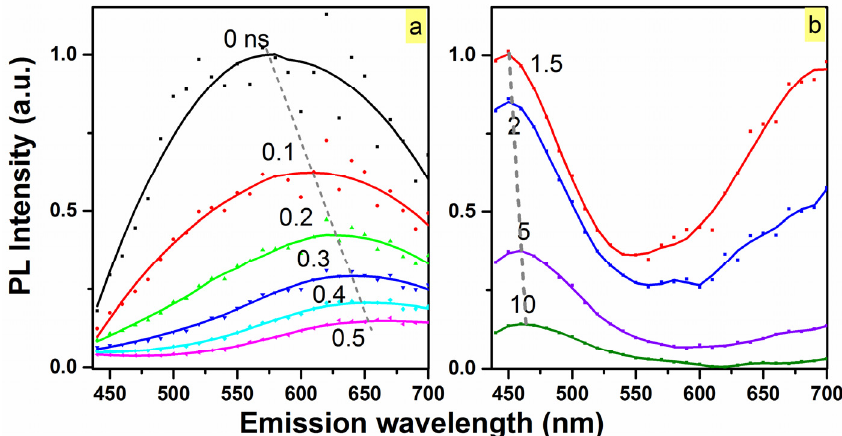
Figure 6. Time evolution of the steady-state PL of the N 2 900 °C passivated SiC 0.3 O 1.6 sample at 77 K. ( a ) Over the first few hundreds of picoseconds, the PL of the ~580 nm component dominates the spectrum before decaying completely; ( b ) Beyond one nanosecond, the ~470 nm component persists in the spectrum up to 50 ns (measurement upper limit-20 MHz repetition rate).